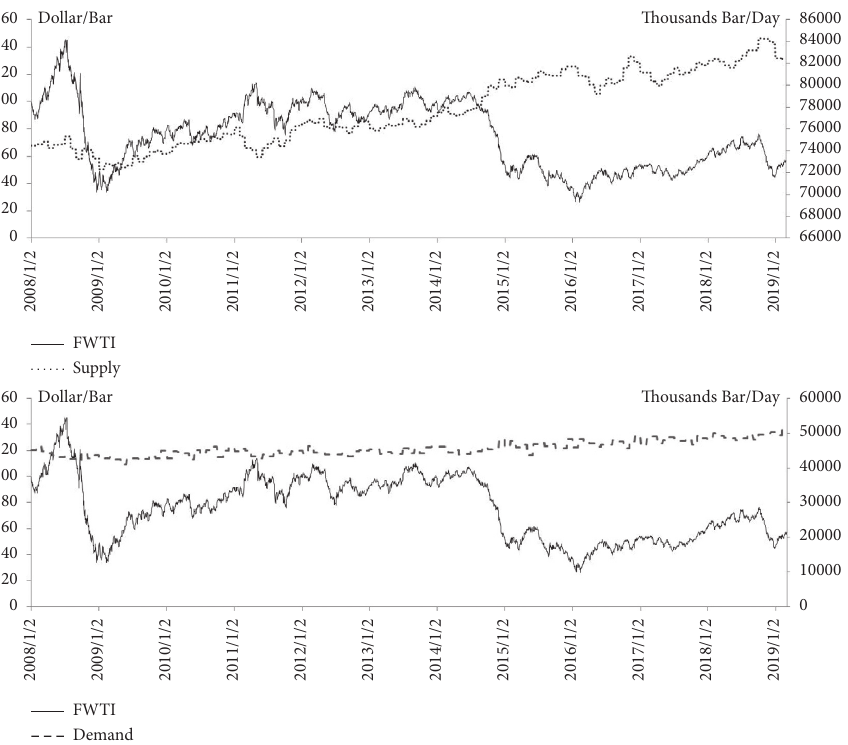
Figure 5: Relation between crude oil future prices, supply, and